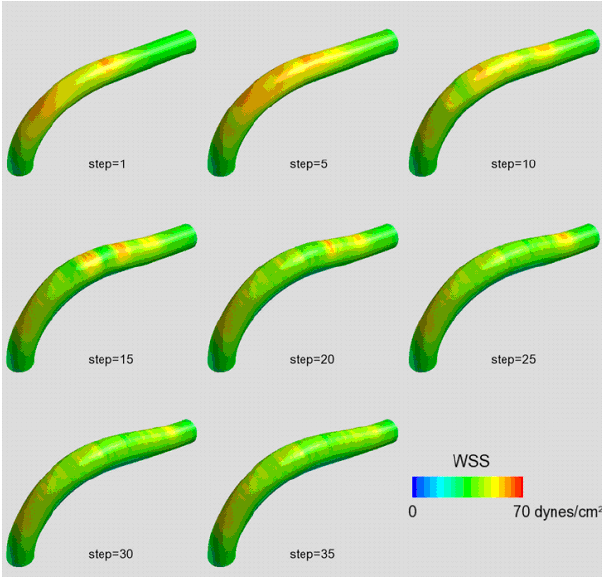
Fig. 7 Progression of aneurysm in the curved model. The aneurysm develops both in the height and width direction. Simulation condition: k=1.5 and τ